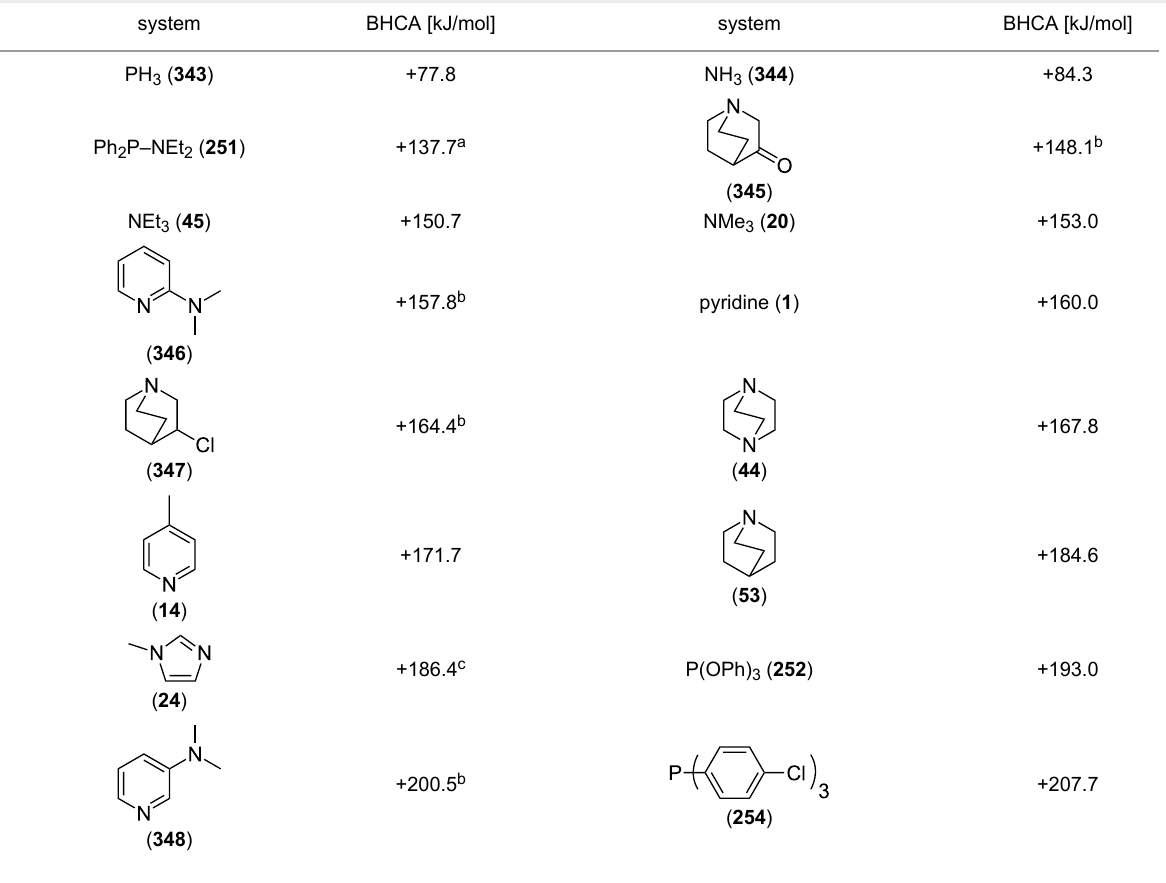
Table 9: BHCA values of Lewis base, ordered by increasing BHCA